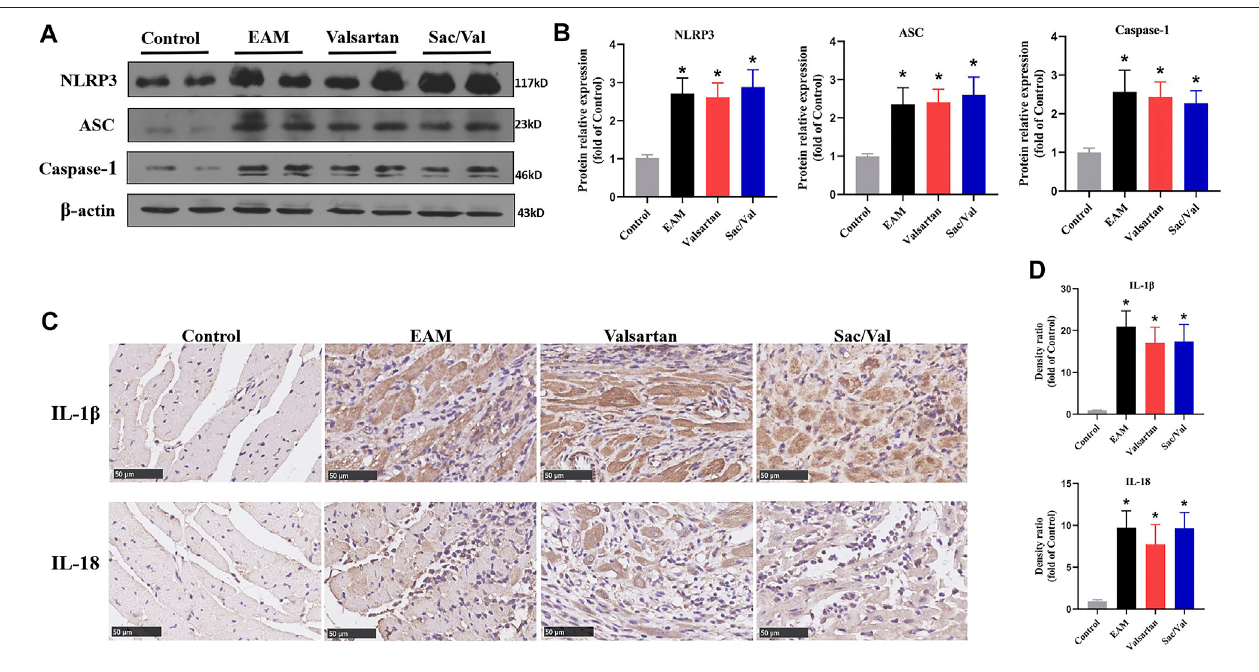
FIGURE2| Sac/ValhadnoeffectonactivationofNLRP3in fl ammasomes. (A) RepresentativewesternblottingresultsforcardiacNLRP3,ASC,andCaspase-1. (B) Statistical analysis of the western blotting results. (C) Representative IHC images of cardiac IL-1 β and IL-18 (magni fi cation × 400). (D) Statistical analysis of the IHC results. All experiments had six mice per group and data were expressed as means ± SEM and analysed by one-way ANOVA. * p < 0.05 vs. Control group.